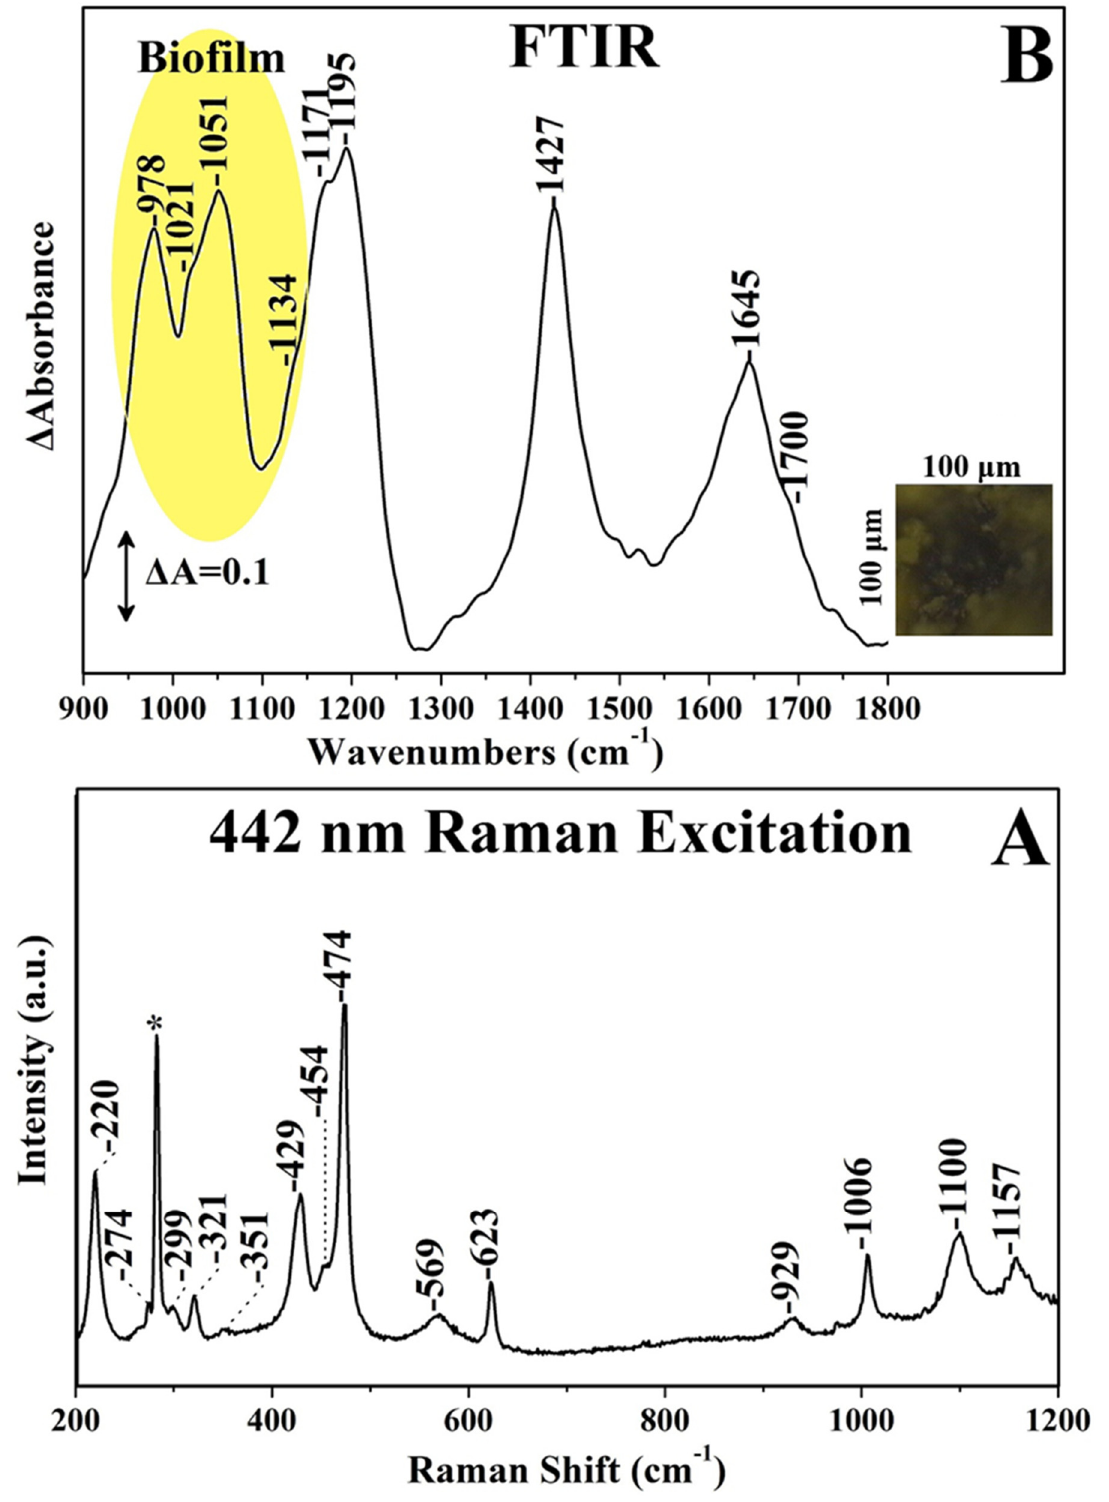
Figure 1. Panel ( A ): 442 nm Raman excitation spectra of bioleached bornite. The laser power incident on the sample was 20 mW and the accumulation time was 15 min. Panel ( B ): 100 × 100 µ m FTIR imaging spectra of the surface of bioleached bornite [Cu 5 FeS 4 ] by Acidithiobacillus ferrooxidans and the FTIR spectra collected from the surface of the mineral. The area of infrared fingerprint is 0.01 mm 2 with spectra resolution of 4 cm − 1 .